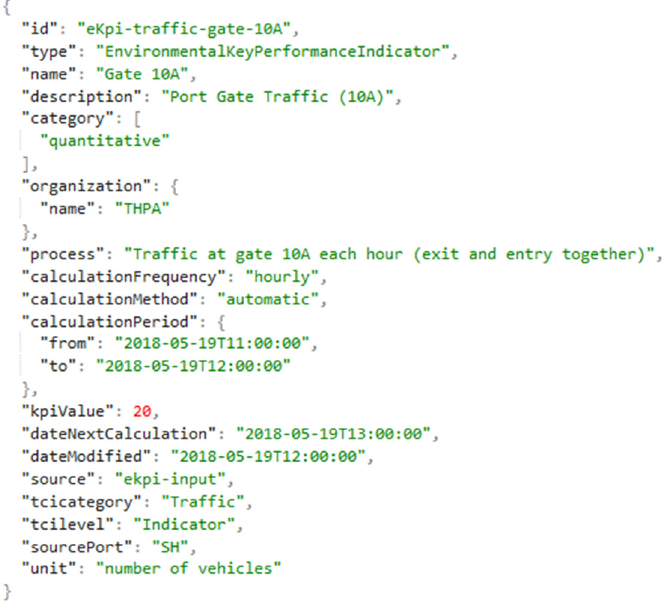
Figure A1. Example of an KPI datamodel.